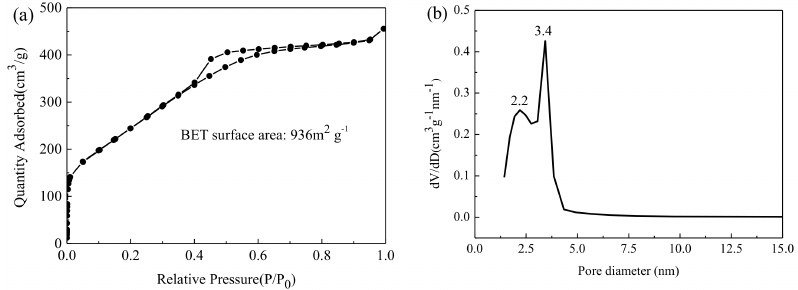
Figure 4. Nitrogen adsorption-desorption isotherm ( a ) and the corresponding pore size distribution of BN products ( b